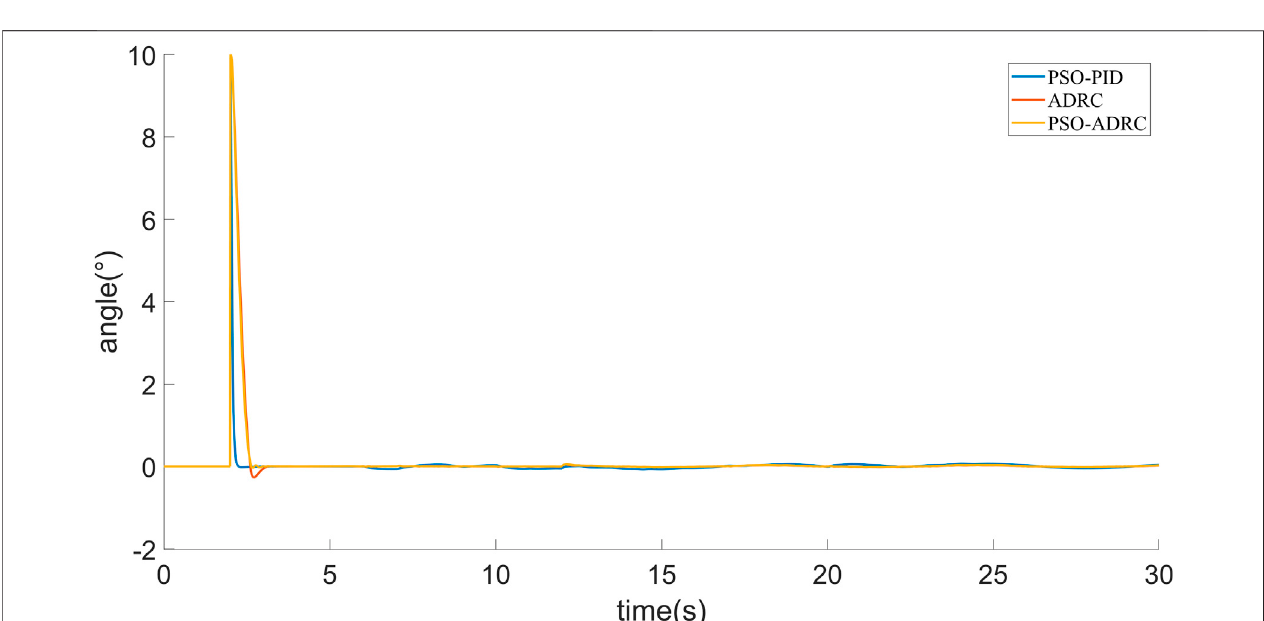
FIGURE 9 | Tracking error under external